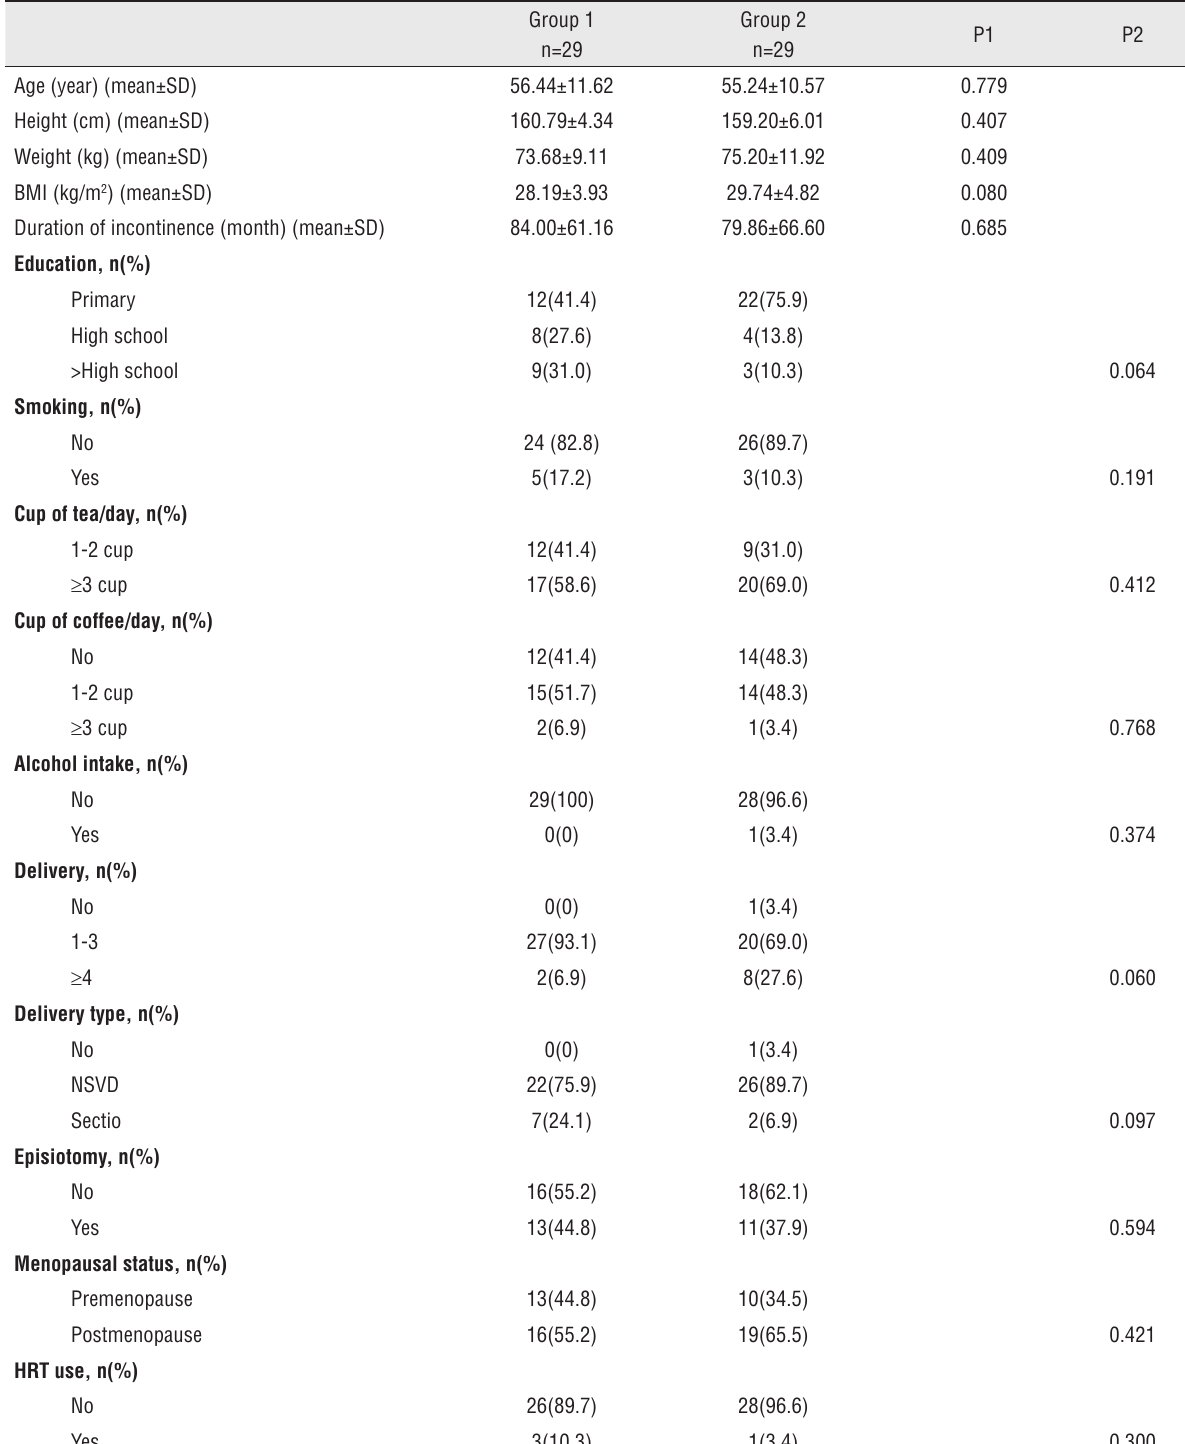
Table 1 - Demographic data of